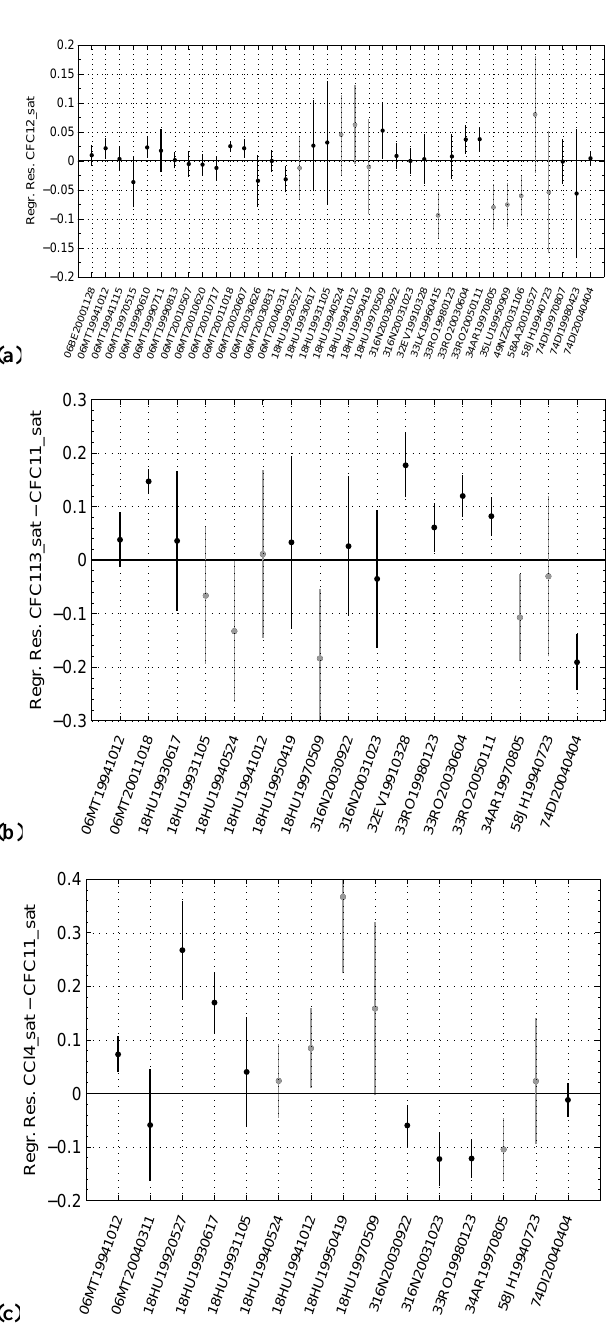
Figure 7 Figure 7. Mean regression residuals for each cruise included into the CARINA-ATL data product between the surface saturation of (a) CFC-12 / CFC-11, (b) CFC-113 / CFC-11, and (c) CCl 4 / CFC-11. Cruises were the CFC-11 data and / or the regressed CFC component have been corrected or flagged as poor are highlighted in grey.